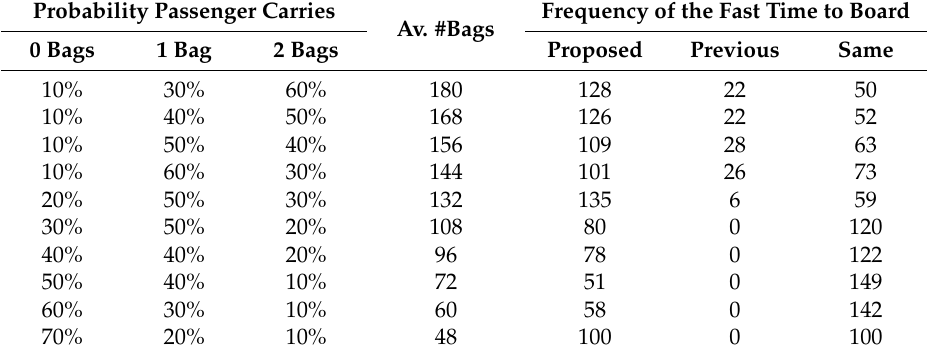
Table 5. Frequency of the proposed method doing better, worse or the same as the previous method in scenario 1.